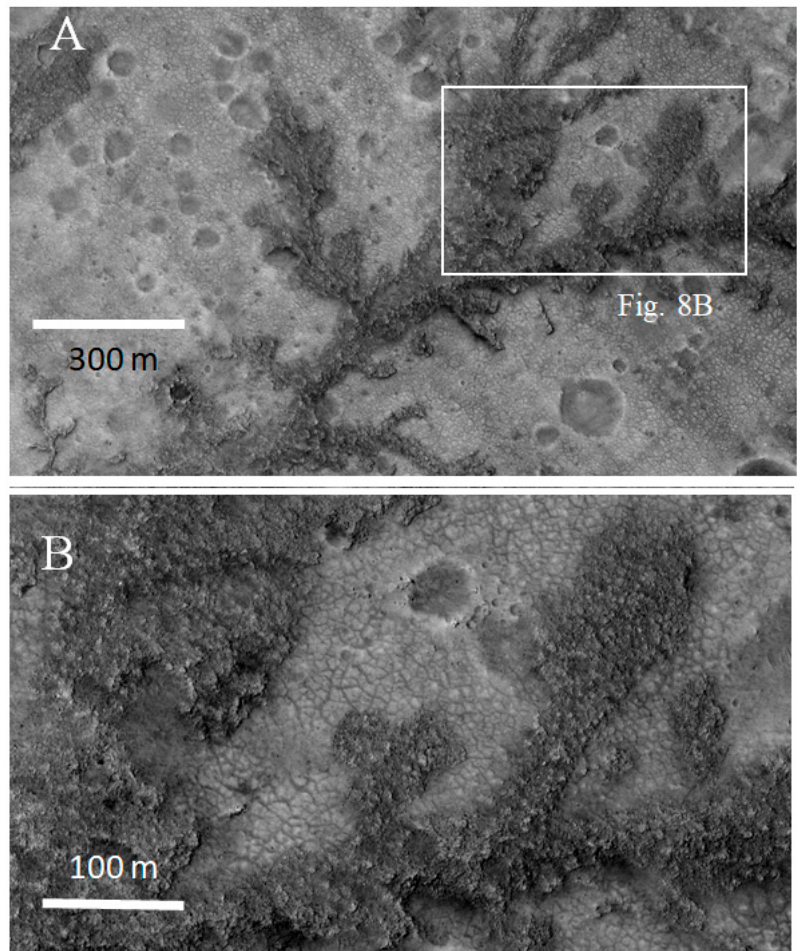
Figure 8. ( A ) Example of dendrites increasing in width with distance from the branching point. The area is shown as a rectangle in Figure 6. ( B ) Magnified version of the image in A. CTX images.